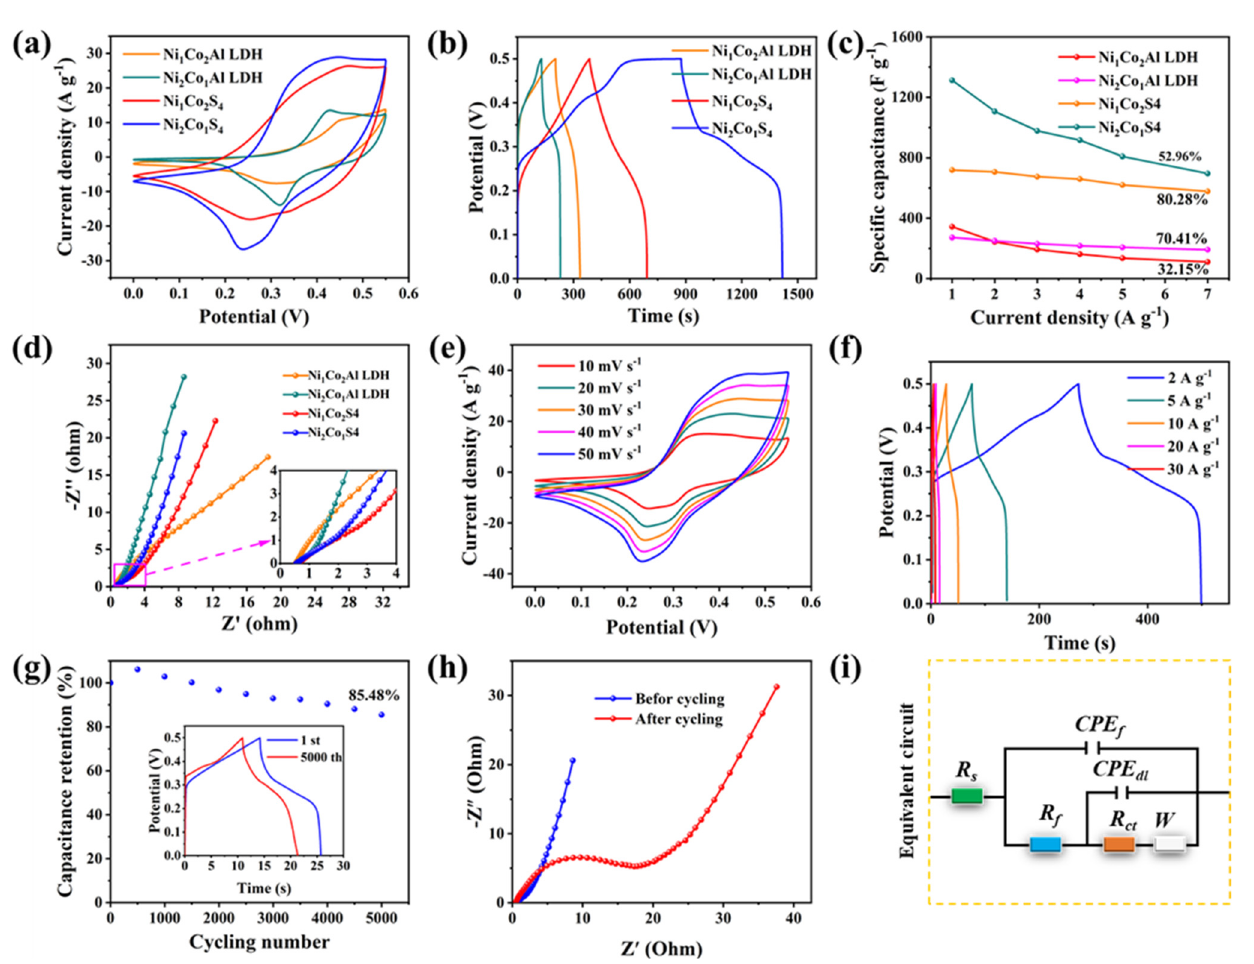
Figure 5. ( a ) CV, ( b ) GCD curves, ( c ) rate capabilities, and ( d ) Nyquist plots of Ni 2 Co 1 Al LDH, Ni 1 Co 2 Al LDH, Ni 2 Co 1 S 4 , and Ni 1 Co 2 S 4 , ( e ) CV, ( f ) GCD curves, ( g ) cycling stability at 3 A g − 1 and GCD curves at 1st and 5000th cycles (inset) of Ni 2 Co 1 S 4 , ( h ) Nyquist plots of Ni 2 Co 1 S 4 before and after cycling, and ( i ) the equivalent circuit for modeling Nyquist